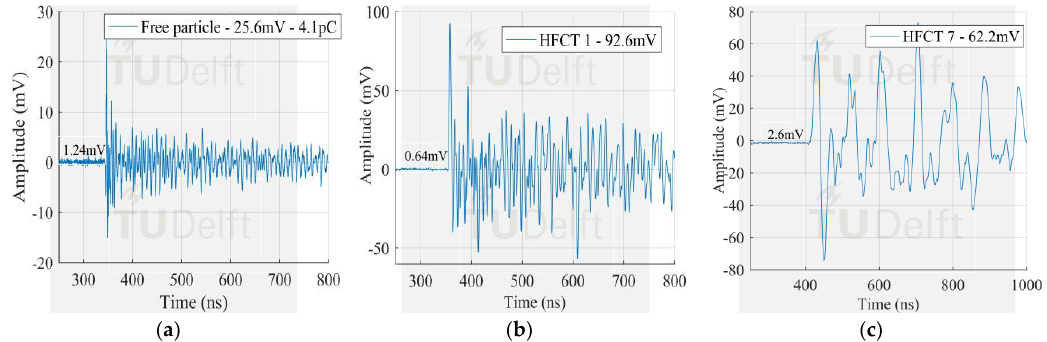
Figure 14. Largest free moving particle signal measured by ( a ) Test cell HFCT; ( b ) HFCT 1; ( c ) HFCT 7.